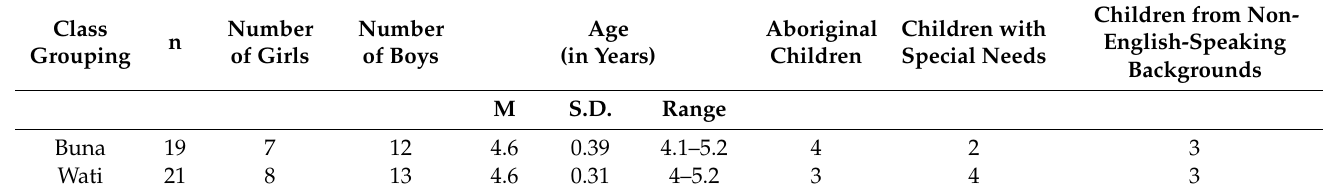
Table 1. Characteristics of child